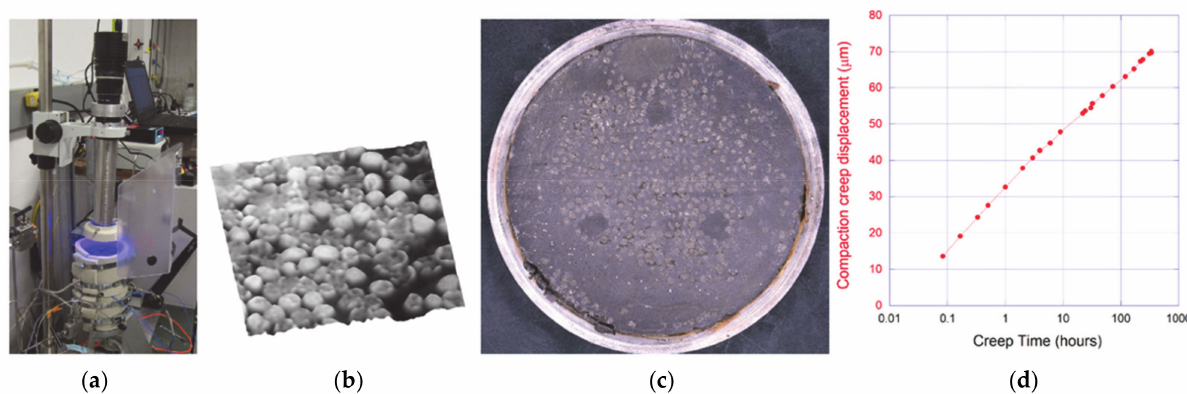
Figure 14. A long-term proppant embedment experiment on a surface of a clay-rich Wolfcamp Shale sample from the HFTS. A lab system which was designed specifically for in-situ optical visualization ( a ). The experiment was conducted at a temperature of 120 ◦ C and an effective stress of 27 MPa, with a monolayer of quartz proppant covering ~50% of a 44-mm diameter sample. In spite of a relatively high clay content in the sample, severe proppant crushing ( b ) and some embedment due to shale matrix deformation ( c ) were observed. The experiment was continued over 2 weeks, and the time-dependent deformation of the fracture was monitored ( d